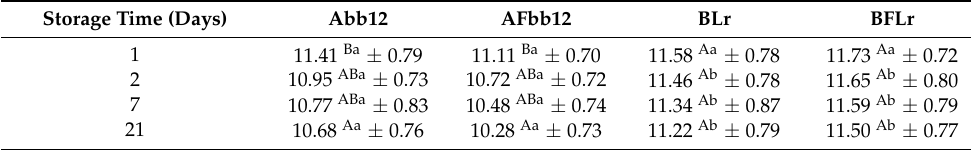
Mean ± standard deviation. n = 20; a,b —Mean values denoted in rows by different letters differ statistically significantly at ( p ≤ 0.05); A,B —Mean values in columns obtained for a given parameter denoted by different letters differ significantly ( p ≤ 0.05). Abb12: sample with 4% inulin and Bifidobacterium bb12, AFbb12: sample with 2.5% inulin, 1.5% apple fiber and Bifidobacterium bb12, BLr: sample with 4% inulin and Lb. rhamnosus ,